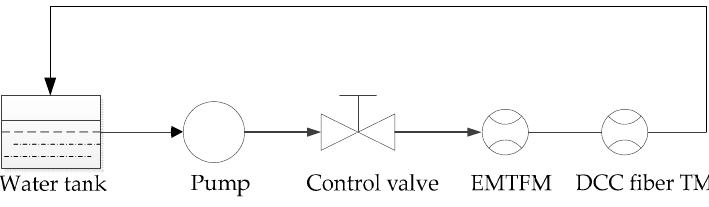
Figure 7. Water flow control loop system schematic diagram.